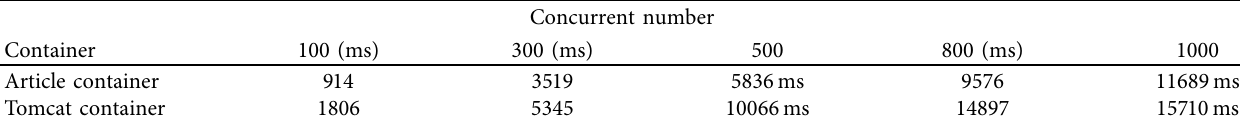
Table 3: Average response time comparison between article container and